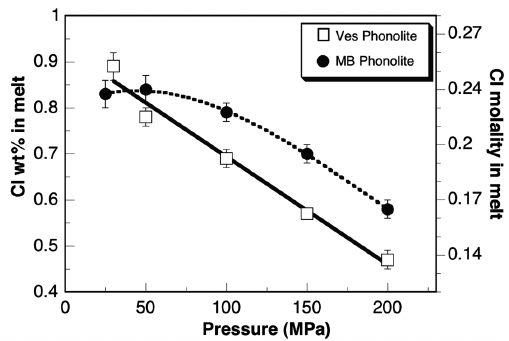
Fig. 3. Chlorine solubility in phonolitic melts satu- rated with aqueous fluid+brine versus pressure. Sol- id circles and open squares represent MB (Montaña Blanca, Teneriffe) and Vesuvius phonolitic glasses ( ± 1 σ standard deviation), respectively (data from Signorelli and Carroll, 2000).